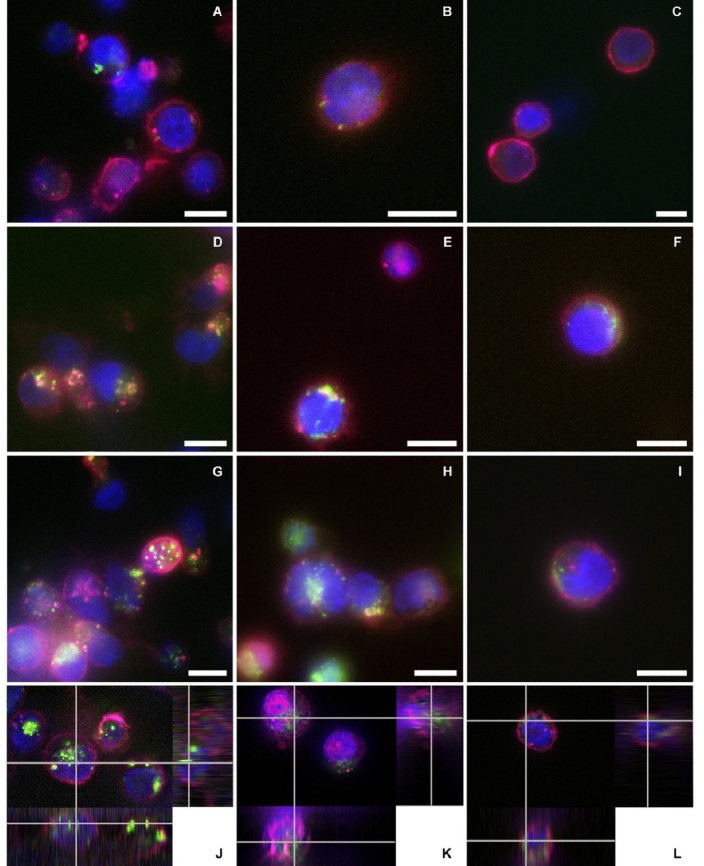
Figure 6. Schemes followed the same formatting. Fluorescence microscopy images of the three cell lines treated with different concentrations of lymphocyte-derived EVs after 48 h of incubation. The blue color represents the cells’ nuclei labeled with Hoechst, purple depicts the cells’ membranes labeled in WGA647, and green shows the nEVs labeled in WGA488. Images of ( A , D , G ) lymphocytes, ( B , E , H ) Daudi, and ( C , F , I ) of HL60 cell lines incubated with a concentration of 5, 10, and 20 µg/mL of nEVs, respectively. Orthogonal views of the internalization of 20 µg/mL nEVs in lymphocytes ( J ), Daudi ( K ), and HL60 ( L ) treated for 48 h. Scale bars: 10 µm.